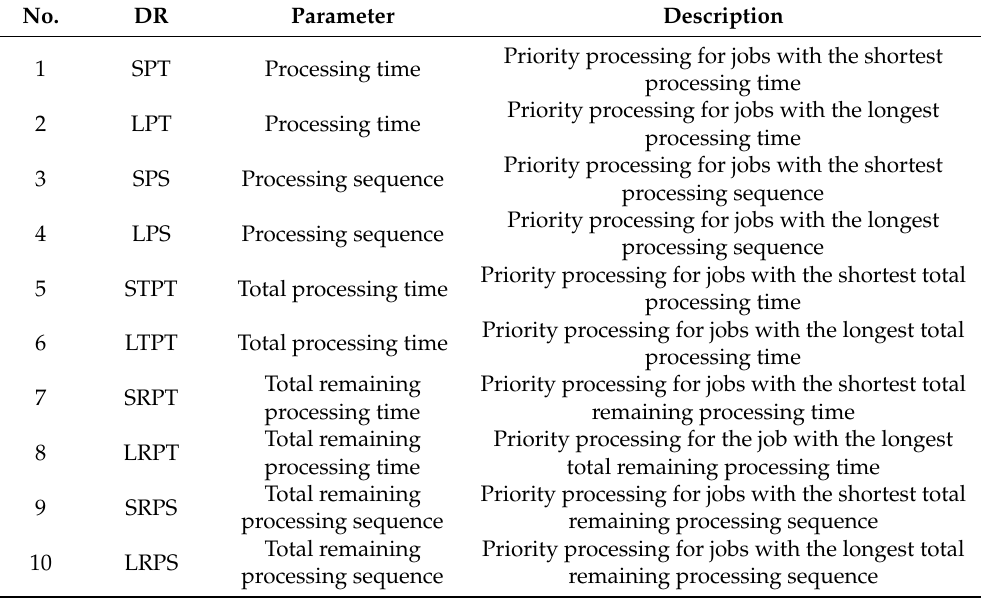
Table 5. Single-parameter